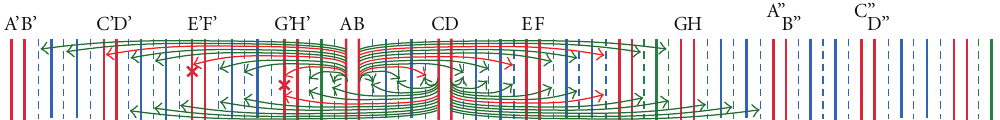
Figure 10: Transitions from nearest electron pairs for ν = 15 /